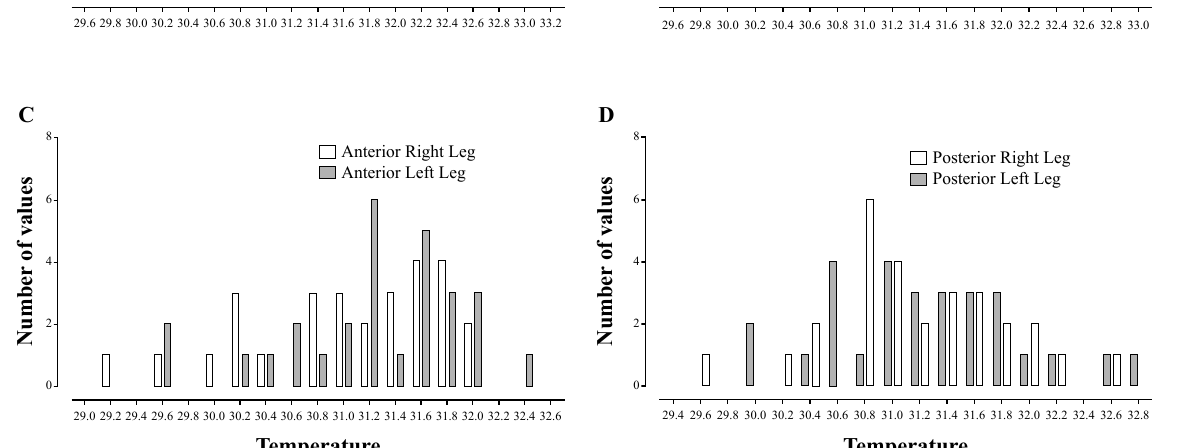
LegAnterior Right Leg Anterior Left Leg